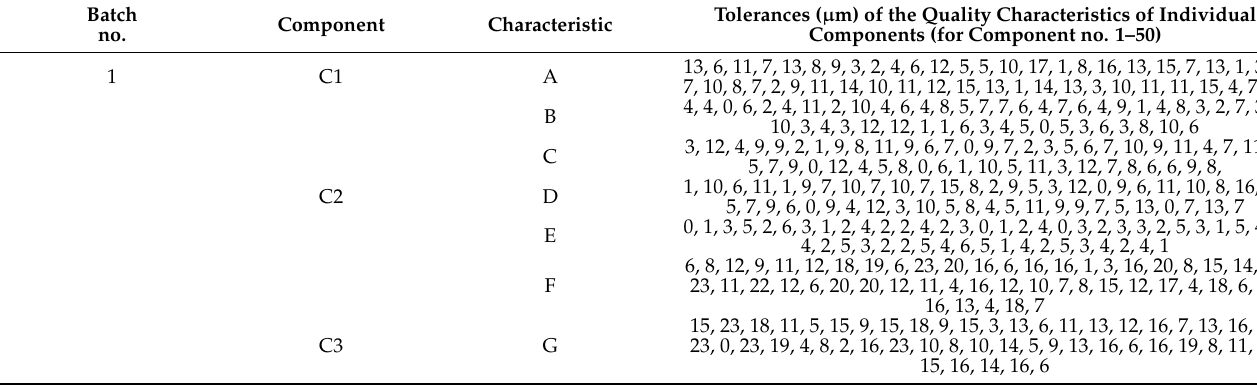
Table A1. Data of the example